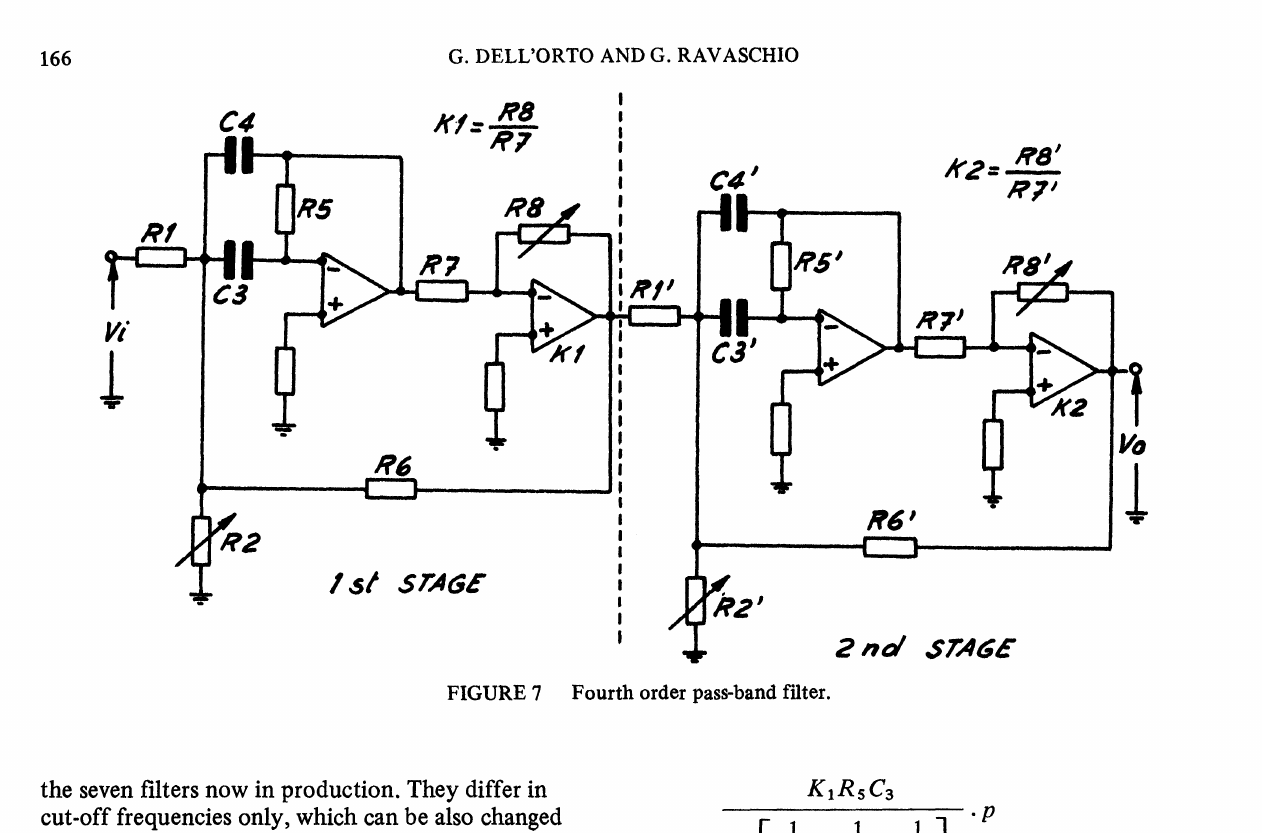
FIGURE 7 Fourth order pass-band